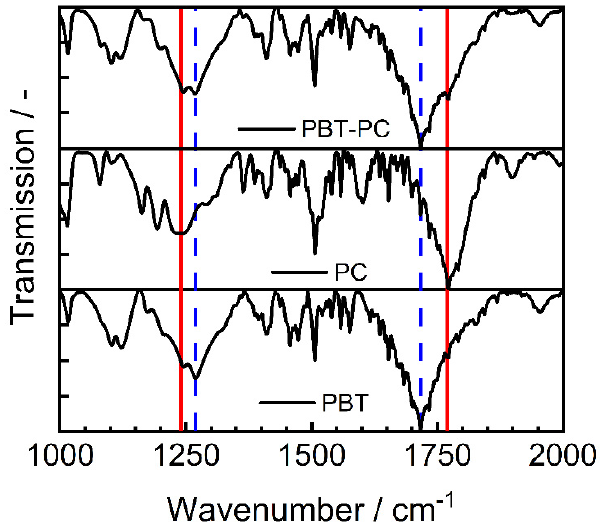
Figure 8. Proof of the blending of PBT and PC during the co-comminution process; PC (red, straight line): O-C-O at 1235 cm − 1 , C=O at 1770 cm − 1 ; PBT (blue, dashed line): O-C-O at 1260 cm − 1 , C=O at 1718 cm − 1 [61–64].